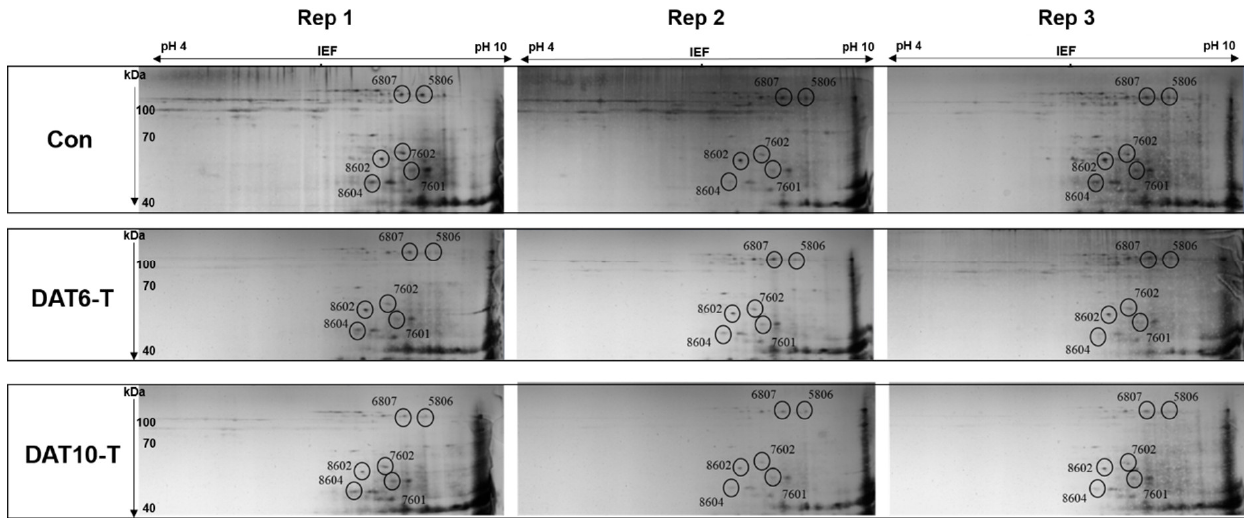
Figure 3. Identification of six glutenin spots with significantly decreased expression levels under high-temperature stress during grain filling. PI ranges are displayed at the top. Protein sizes are displayed to the left. Con, nontreated control; DAT6-T, 6 days of treatment; DAT10-T, 10 days of treatment. Three biological replicates were used (Rep. 1–3). The numbers near the circles indicate spot numbers.